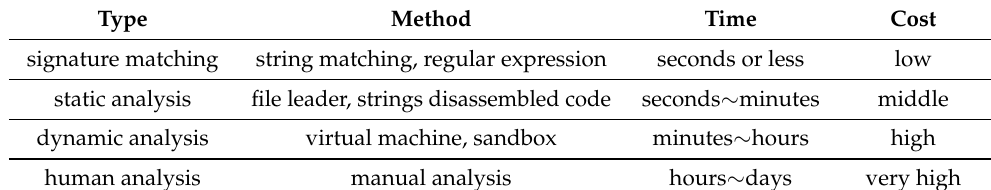
Table 2. Comparison of malware analysis methods in terms of time and cost.